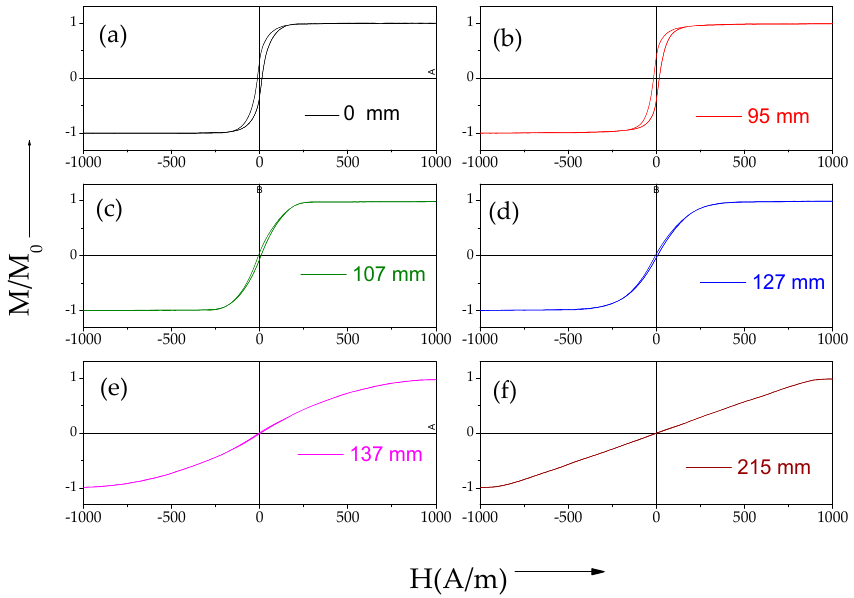
Figure 5. Hysteresis loops of sample 1 stress-annealed variable T ann and σ ≈ 500 MPa. T ann evaluated from Figure 3 are: 25 °C ( a ); 249 °C ( b ); 277 °C ( c ); 290 °C ( d ); 295 °C ( e ); and 300 °C ( f ), respectively.